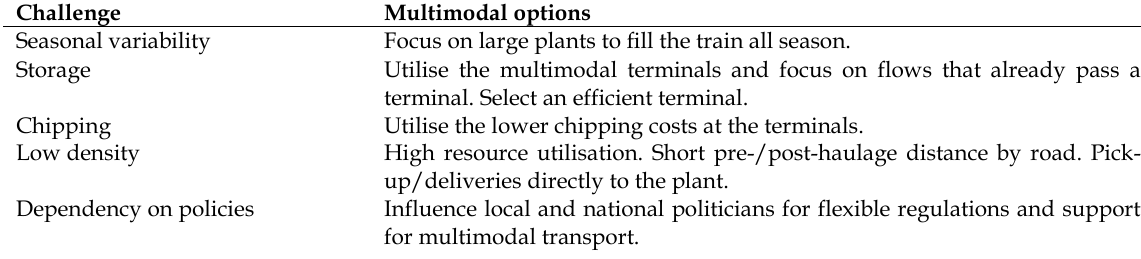
Table 5. Logistical biofuel challenges and the multimodal options Challenge Multimodal options Seasonal variability Focus on large plants to fill the train all season.